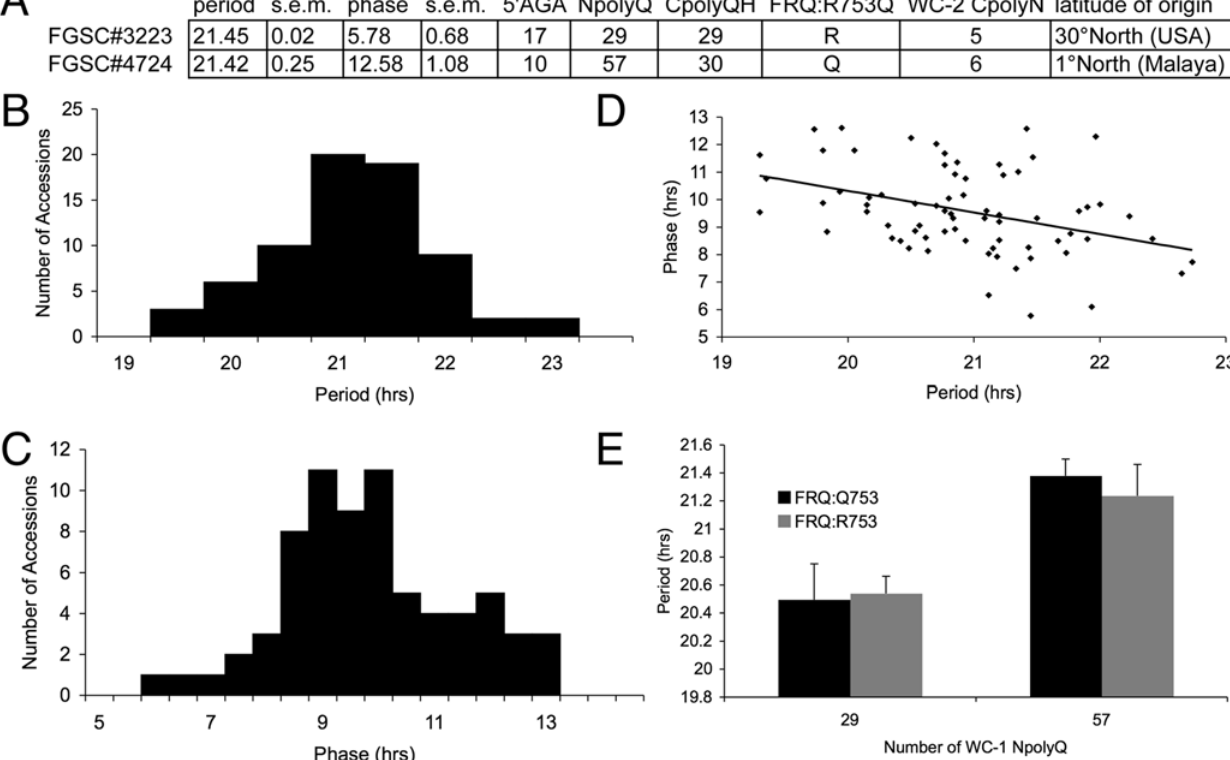
Figure 5. WC-1 genotype segregates with period length in a cross between two N.crassaaccessions. (A) Period, phase, genotype and latitude of collection information for the parental strains FGSC # 3223 and FGSC # 4724 at 25 u C. Period (B) and phase (C) were measured for both parental strains (FGSC # 3223 and FGSC # 4274) as well as for 69 progeny from the cross (Table S2). (D) Association between period and phase of the progeny. (E) Period length was significantly associated with WC-1 genotype, regardless of FRQ genotype ( P , 0.001). Since FRQ and WC-1 are on the same chromosome (linkage group), we scored FRQ: Q753R for crossover events between the two loci. Eleven crossover events were identified in the 69 progeny, FRQ: Q753 (black) and FRQ: R753 (grey). Average period and phase of two biological replicates are presented, and data available in Table